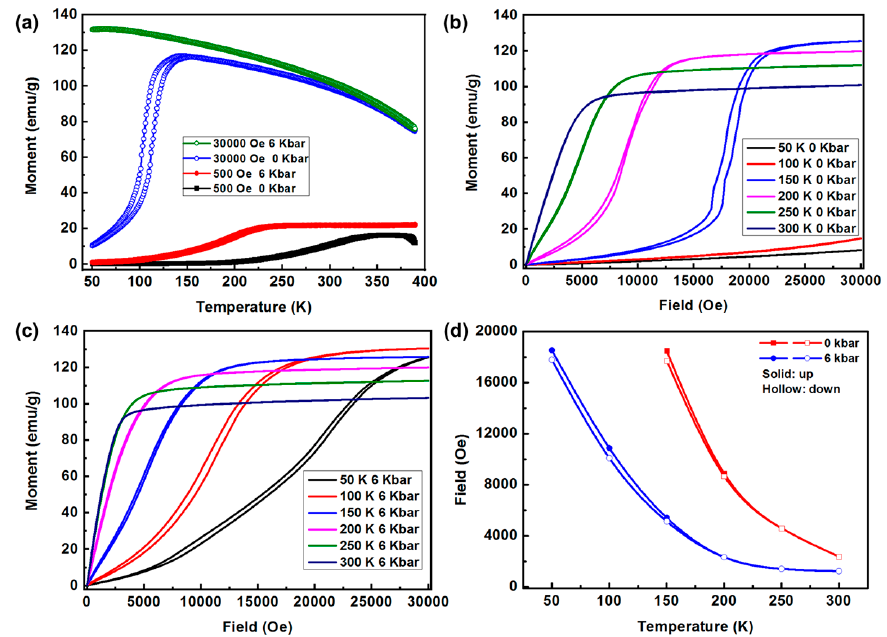
Figure 2. ( a ) The thermomagnetic loops (M-T) were measured upon heating and cooling with 0 kbar and 6 kbar for MnCo 0.92 Ni 0.08 Si alloy at the magnetic field of 500 Oe and 30,000 Oe. Field-up and field-down isothermal magnetization curves (M-H) within the magnetic range between 0~30,000 Oe ( b ) ambient pressure and ( c ) 6 kbar. ( d ) The temperature dependence of critical fields for driving meta-magnetic transition field-up and field-down processes at different hydrostatic pressure derived from ( b , c ). Figure 2b,c present the isothermal magnetization (M-H) curves of MnCo 0.92 Ni 0.08 Si at ambient pressure and selected hydrostatic pressure (6 kbar), respectively. At 50 K and 100 K, the magnetization varies almost linearly under field up to 30,000 Oe with little increase under ambient pressure, indicating the alloy maintains an AFM state. As the temperature increased to 150 K, a meta-magnetic transition from AFM to FM is observed, exhibiting a sharp increase over a critical magnetic field (H cr , defined as a magnetic field corresponding to 50% of saturation magnetization [8]) followed by saturation. There is noticeable hysteresis between field-up and field-down plots. Furthermore, the